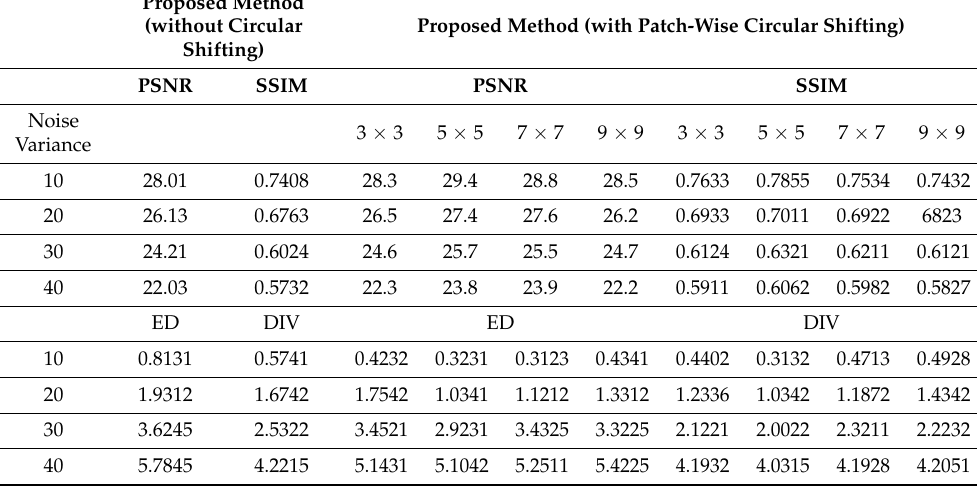
Table 1. Average results (87 images) of performance metrics (PSNR, SSIM, DIV, and ED). Proposed Method (without Circular Shifting) Proposed Method (with Patch-Wise Circular Shifting) PSNR SSIM PSNR SSIM Noise